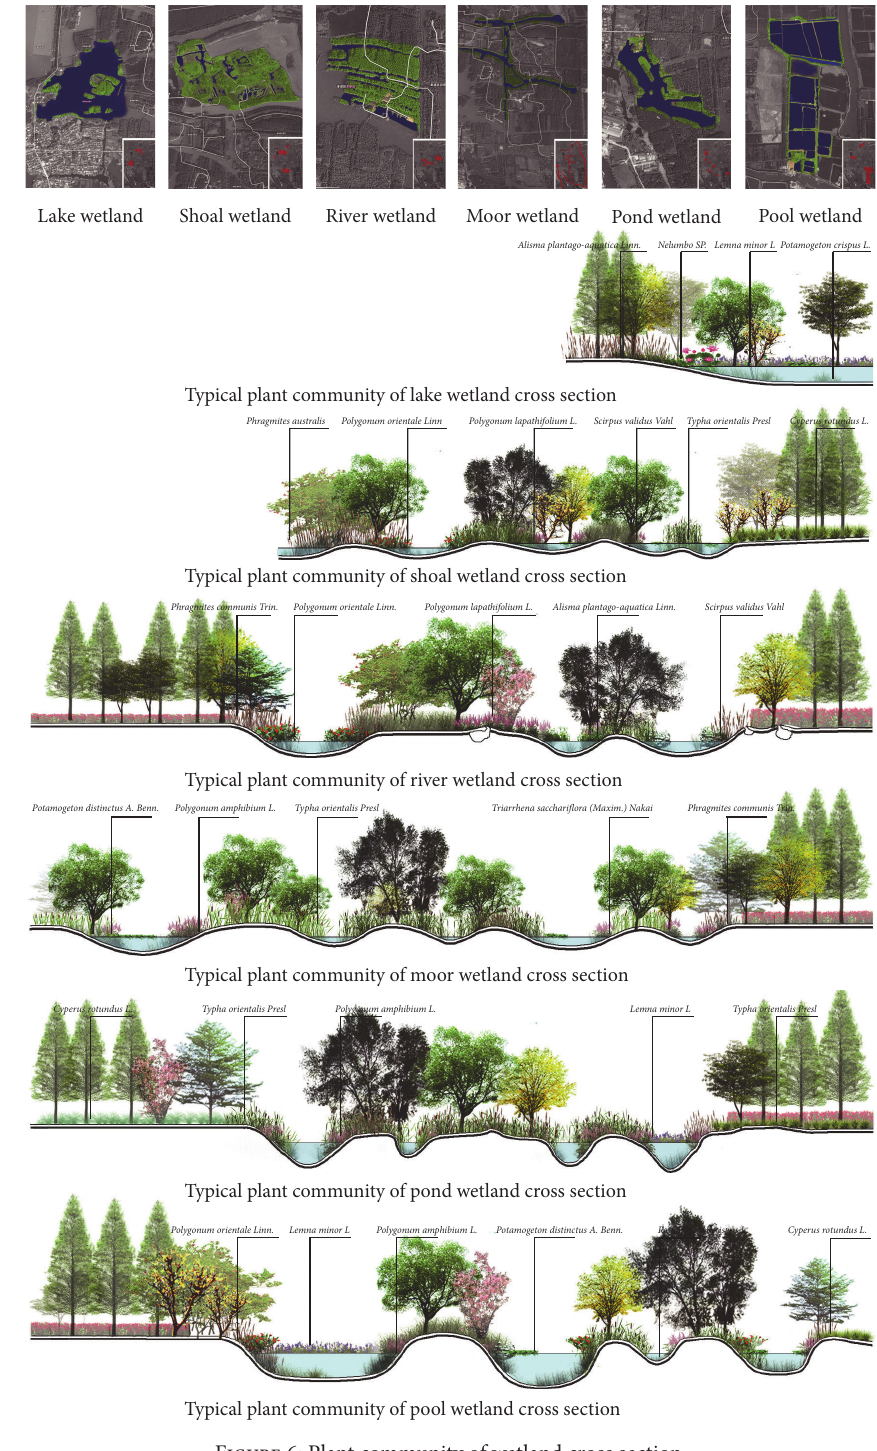
Figure 6: Plant community of wetland cross